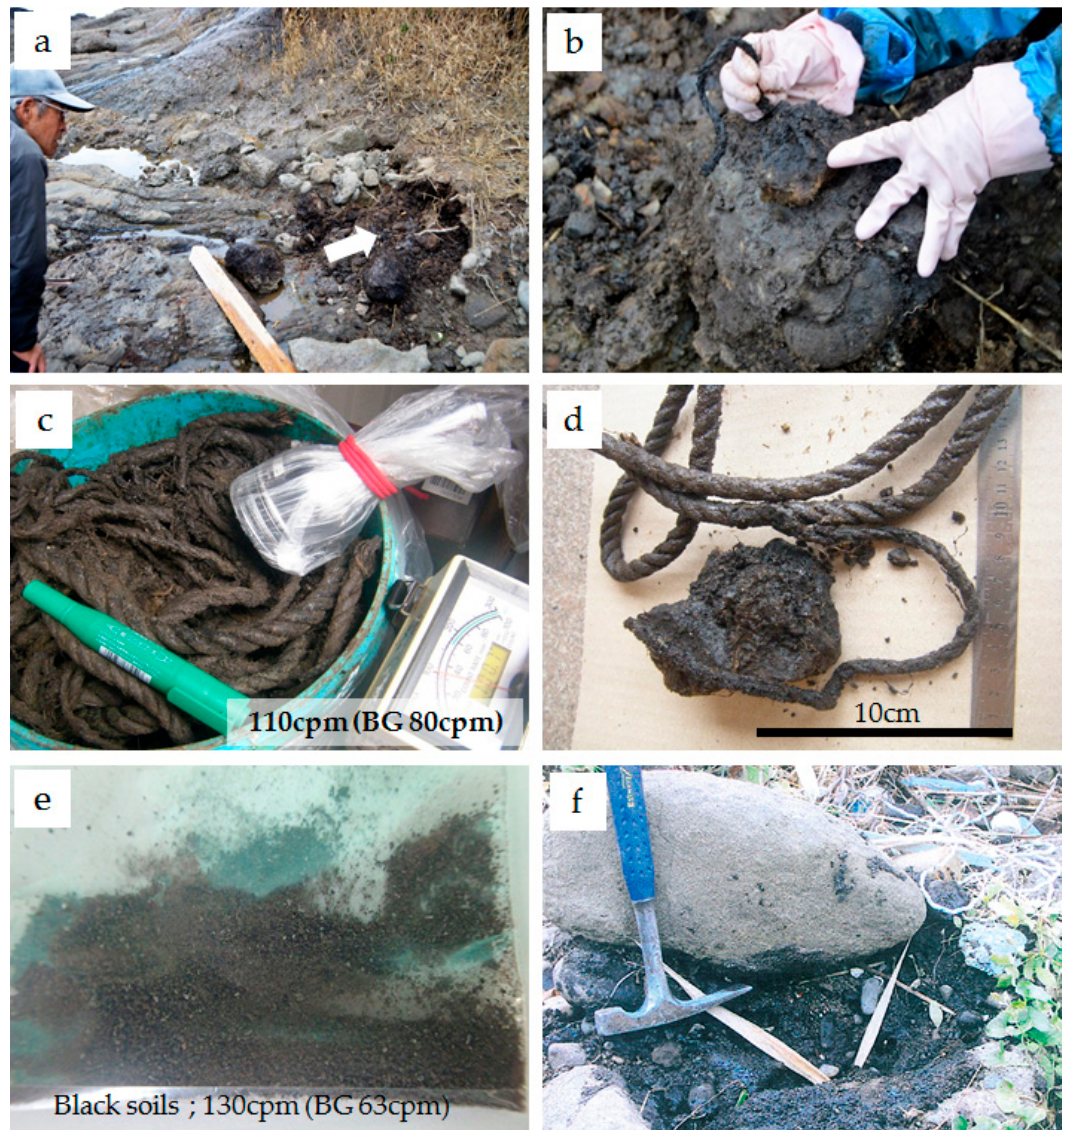
Figure 2. Collected heavy oil with rope and fishing rope and nets on the Atake seashore, Wajima, Ishikawa, Japan in 2017 ( a – d ); detected radiation of 110 cpm (BG 80 cpm) ( c ); black soils also detected radiation of 130 cpm (BG 63 cpm) on 2 May 2017 ( e ); the black soils contained C (11.6%), H (1.8%),